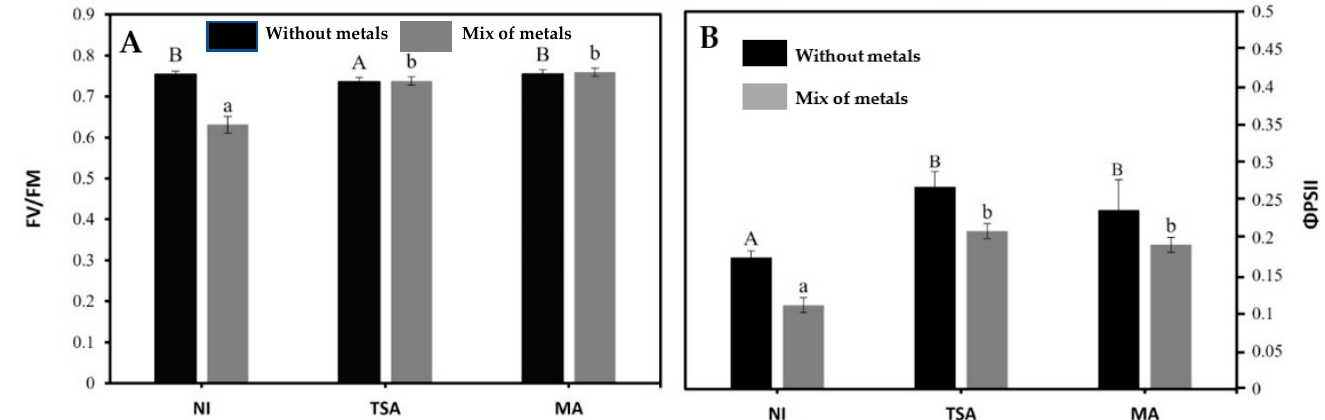
Figure 2. ( A ) Maximum quantum efficiency of PSII photochemistry (Fv/Fm), and ( B ). Quantum efficiency of PSII ( ɸ PSII) of Mesembryanthemum crystallinum plants grown in the absence (black bars) and presence (gray bars) of a mixture of metals and metalloids (10 µM As + 1 µM Cd + 20 µM Cu + 50 µM Zn) and inoculated with TSA or MA consortiums. NI: non-inoculated control. Data are means of 7 independent determinations in 7 different plants ± standard deviations. Statistically significant differences with regard to the non-inoculated control plants at p < 0.05 are indicated by different letters (upper case for the plants grown in the absence of metals and lower case for plants grown in the presence of a mix of metals).